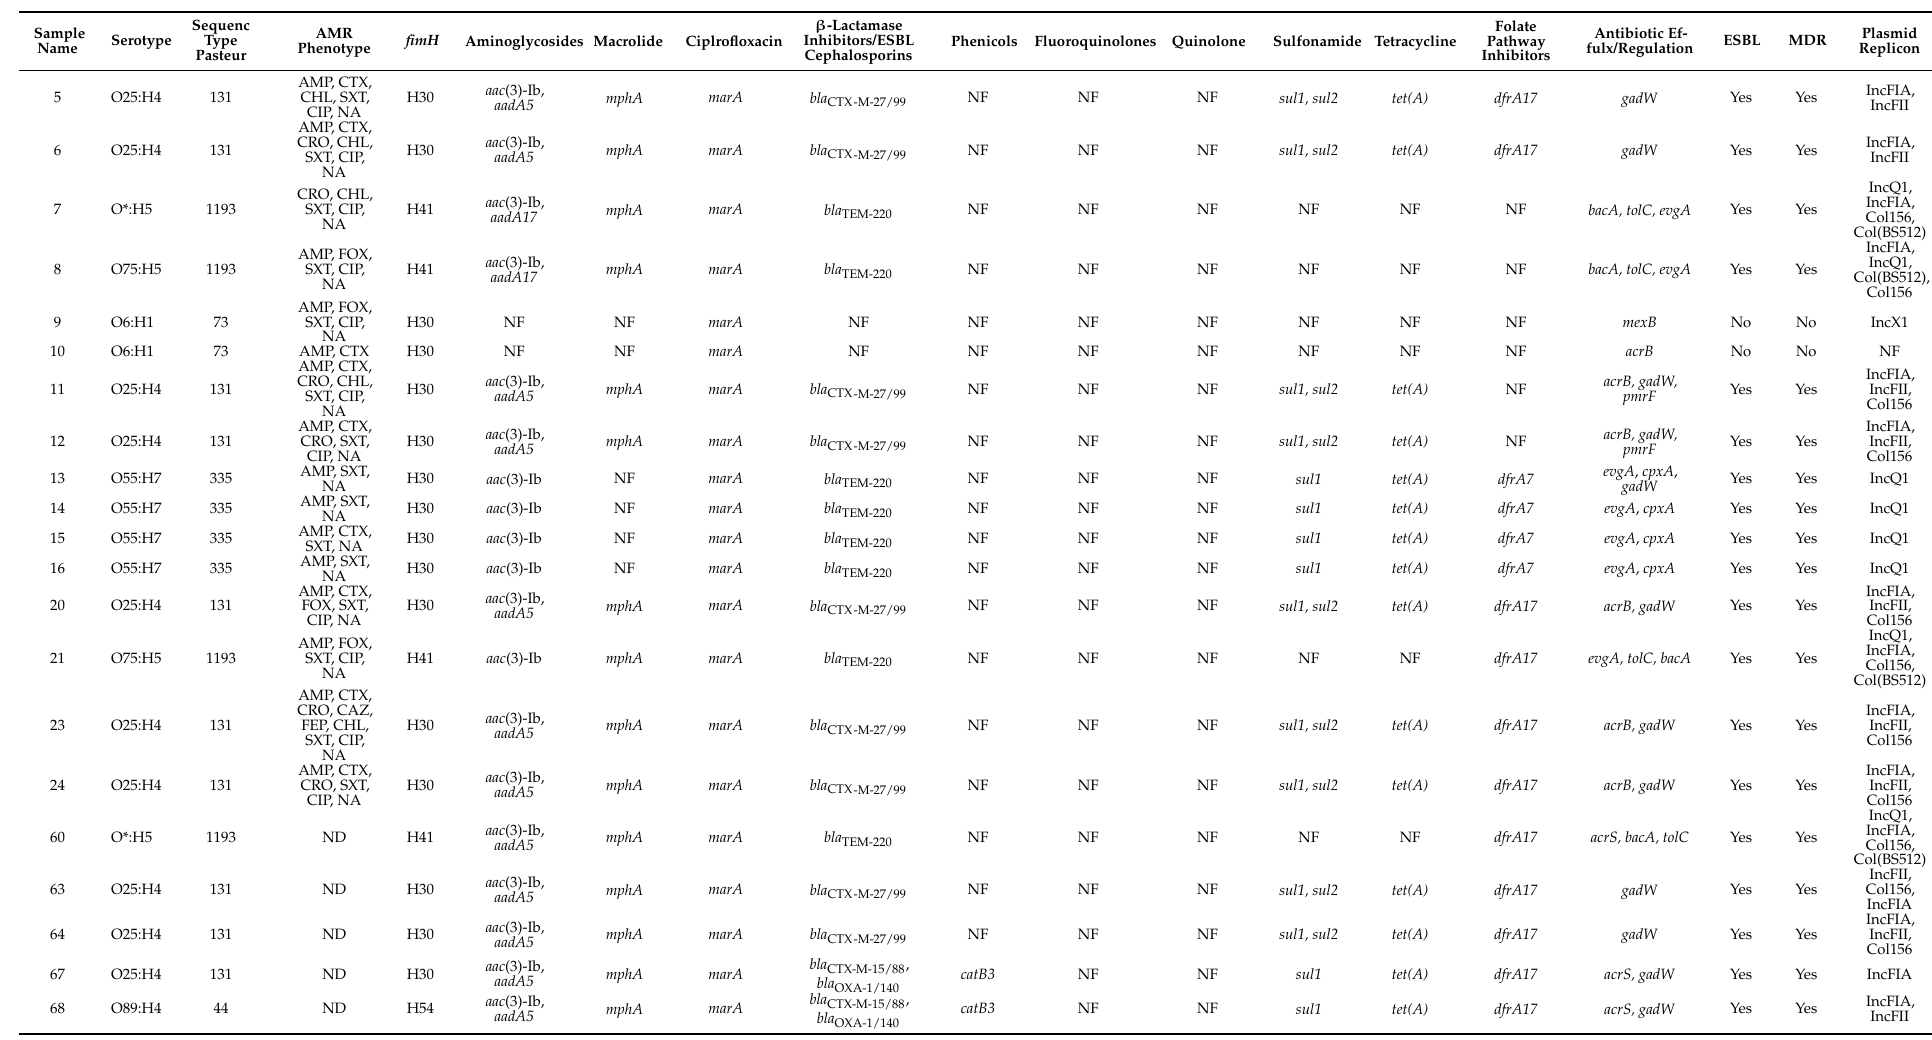
Table 2. Genomic characteristics of uropathogenic E. coli strains isolated in this study for acquired AMR-associated genes and plasmid replicon types. Asterisk (*) next to the O antigen type means undefined; NF means not found; ‘Yes’ means the strain is either ESBL-producing or MDR; and ‘No’ means the sample is either non-ESBL or